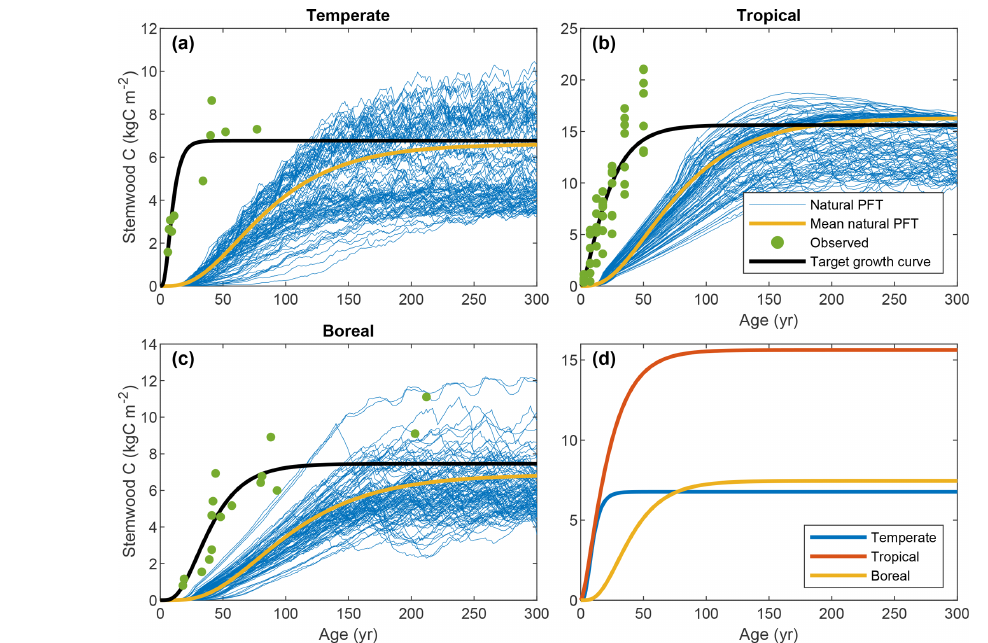
Figure 2. Target growth curves for stemwood C, associated observations, and LPJmL output for natural vegetation in the cells selected for